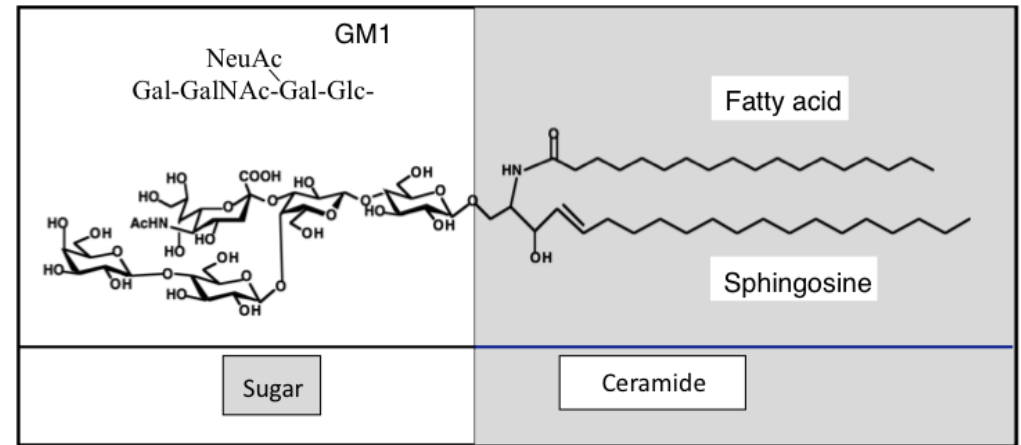
Figure 1. Glycosphingolipids are amphipathic molecules, expressed in the out layer of lipid two layers of the cell membrane. The hydrophobic portion (ceramide) is embedded in the outer layer of the membrane, and the sugar portion is protruding outside the membrane. A representative GM1 structure is shown. Ganglioside nomenclature is according to Svennerholm [10].